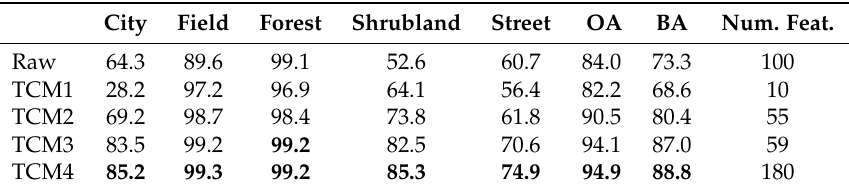
Table 3. Summary of the classification results (in percent) for TomoSAR CM features without phase. Best accuracies are indicated in bold font.